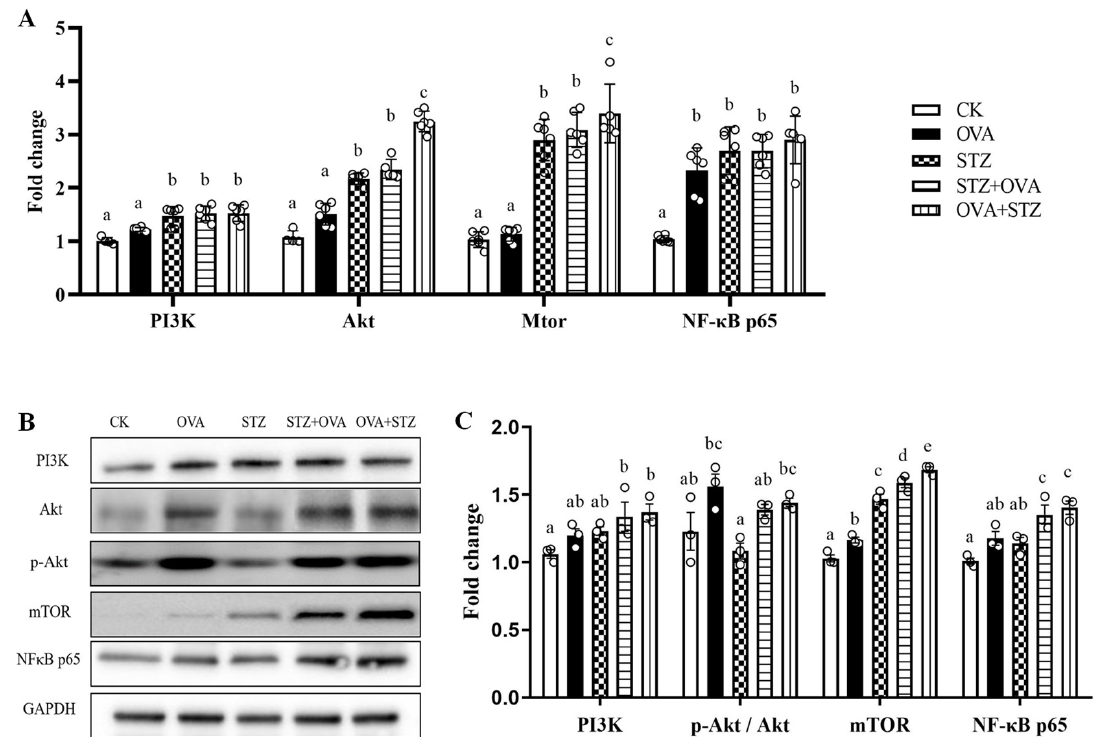
Figure 7. Food allergy affects diabetes by upregulating the expression of PI3K/Akt/mTOR/NF- κ B p65. ( A ), mRNA expression of PI3K/Akt/mTOR/NF- κ B p65 in jejunum. ( B ), Western blotting of PI3K/Akt/mTOR/NF- κ B p65 in jejunum. ( C ), Quantitative analysis of Western blot results of Figure 3M. The error bars indicated the mean ± SEM. n = 6. Different lowercase letters in the figure represent significant differences between the groups ( p < 0.05 by one-way ANOVA followed by SNK). Taken together, these results emphasized that the PI3K/Akt/mTOR/NF- κ B p65